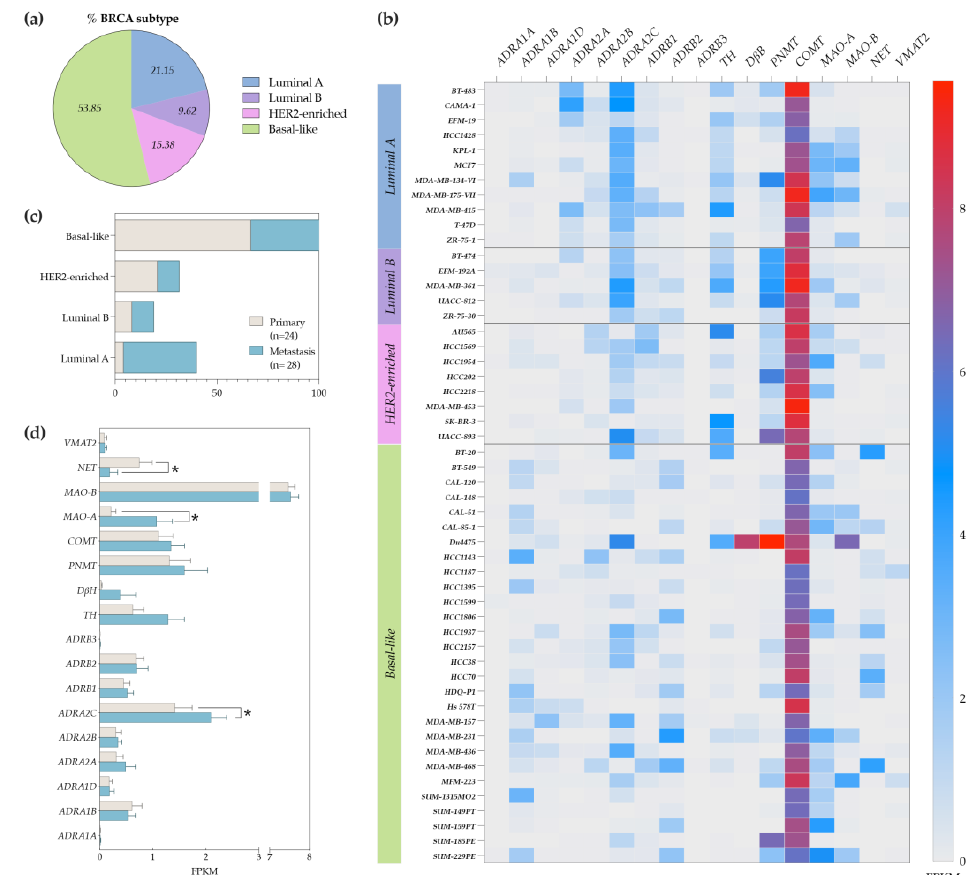
Figure 6. Adrenergic profile of human BC cell lines (dataset obtained from CCLE database). ( a ) Per- centage of human BC cell line subtypes. ( b ) Heatmap depicting the gene expression of sympathetic markers for all human BC cells lines analyzed and categorized by each BC subtype. ( c ) Human BC cell lines subdivided in primary versus metastasis cell lines. ( d ) Gene expression of sympathetic markers on primary versus metastasis of human BC cell lines. p -value < 0.05 (*) was considered statistically significant.